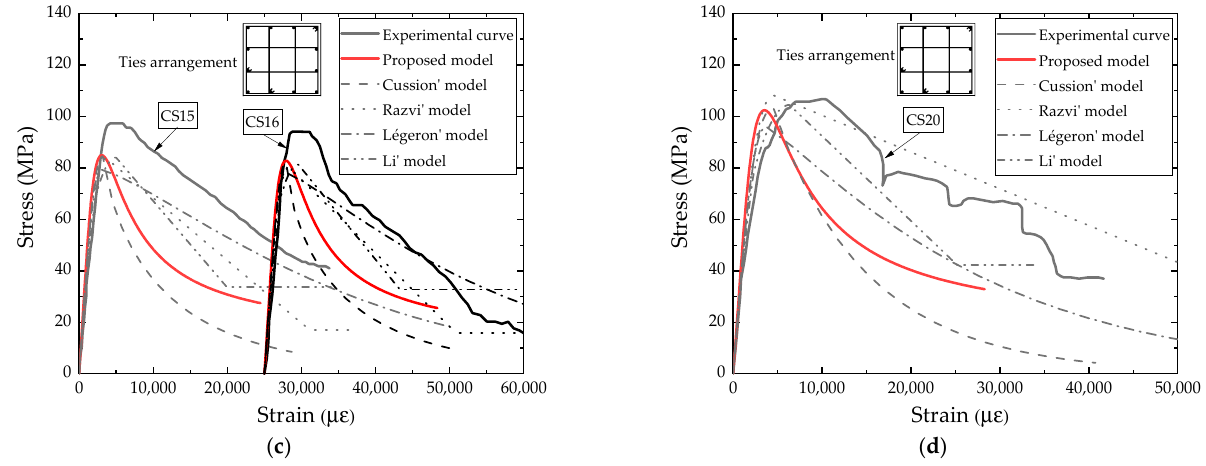
Figure 18. Comparison of experimental curves and analytical models (Razvi,1999): ( a ) CS-3 and CS-5; ( b ) CS-4 and CS-8; ( c ) CS-15 and CS-16; ( d ) CS-20.